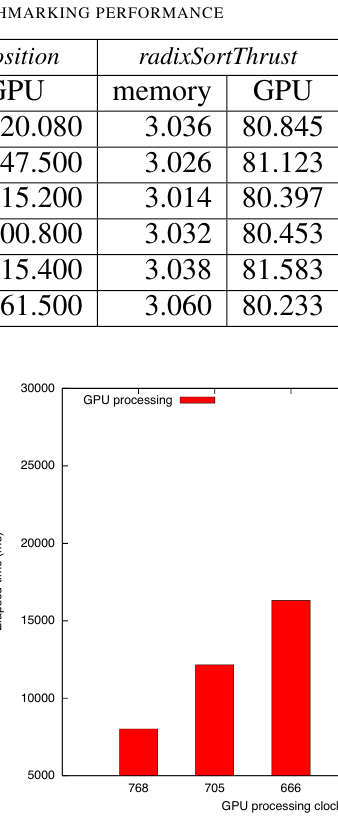
Figure 14. GPU processing elapsed time ( cdpLUDecomposition ).